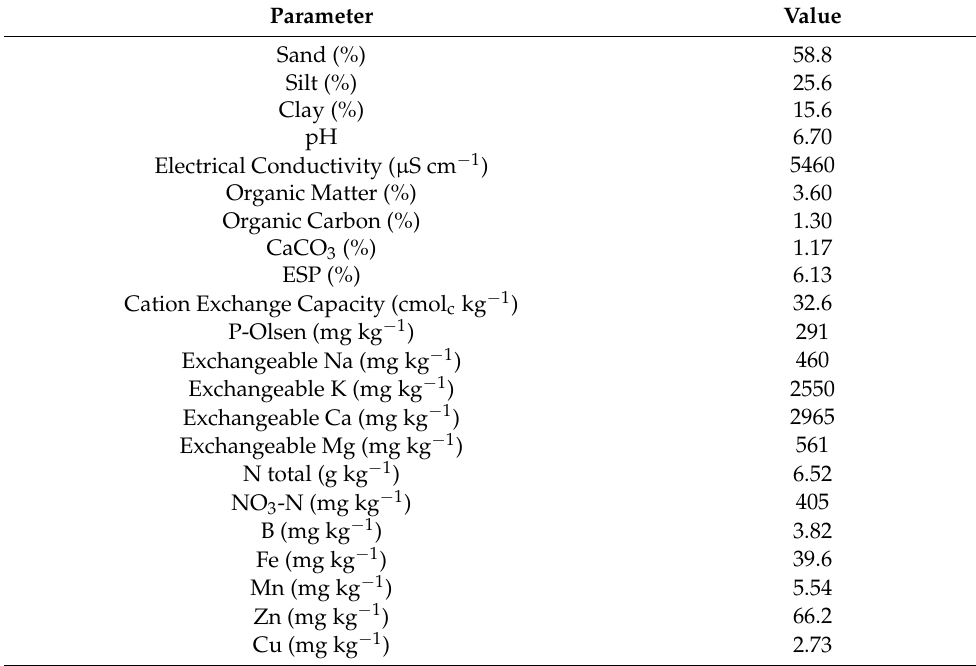
Table 1. Main physicochemical characteristics of used bio-mixture.